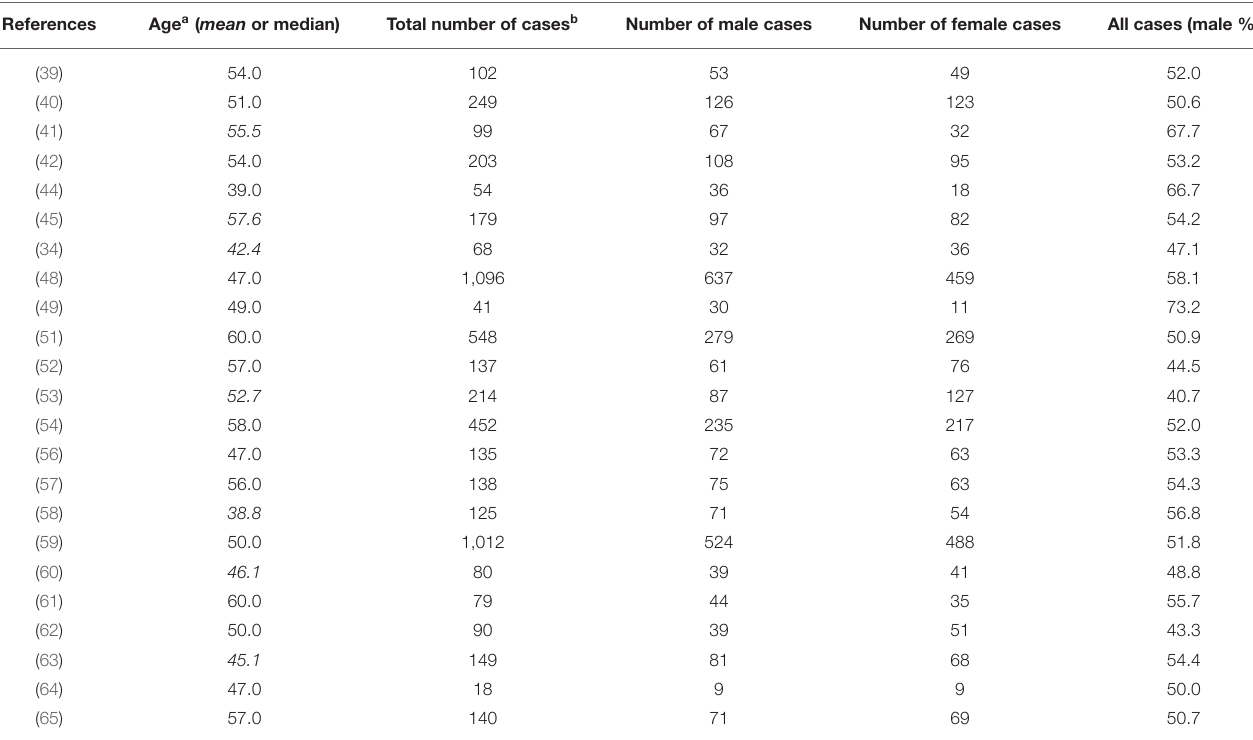
TABLE 3 | All confirmed cases of COVID-19 included in the